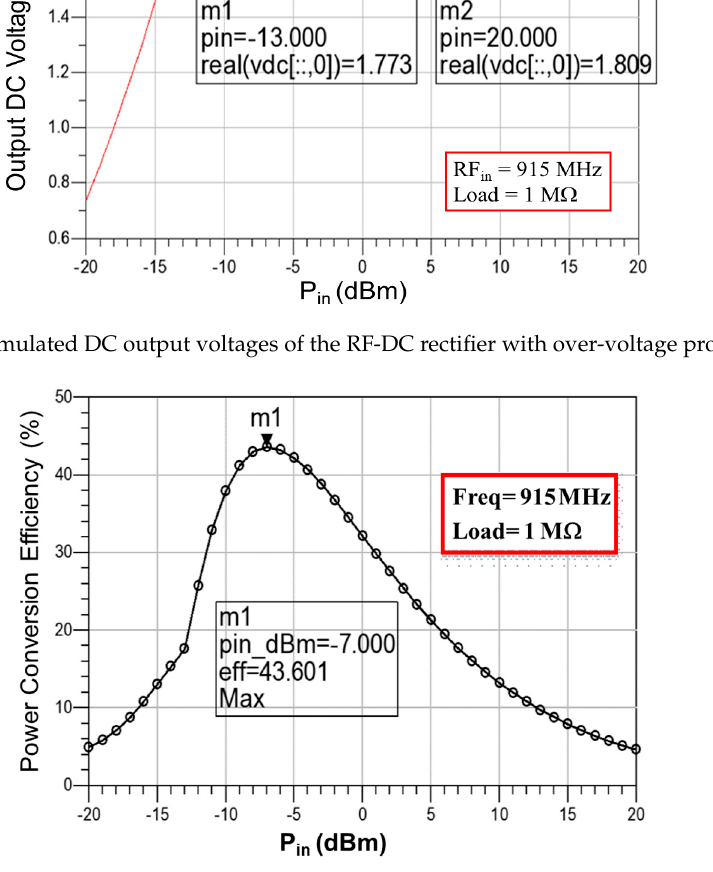
Figure 11. Simulated PCE of the RF-DC rectifier with over-voltage protection (rectifier PCE ), whose PCE was approximately 43.6% at the input power of − 7 dBm.